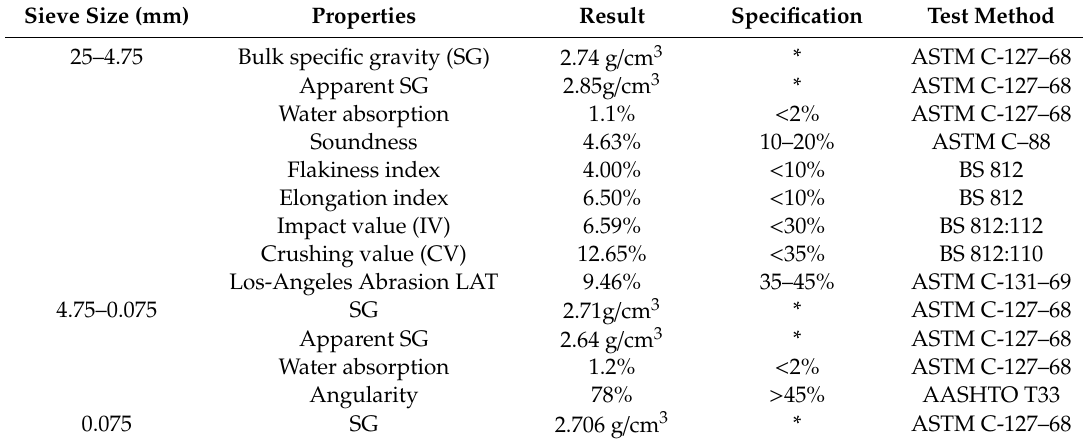
Table 1. Characteristics of the aggregate.